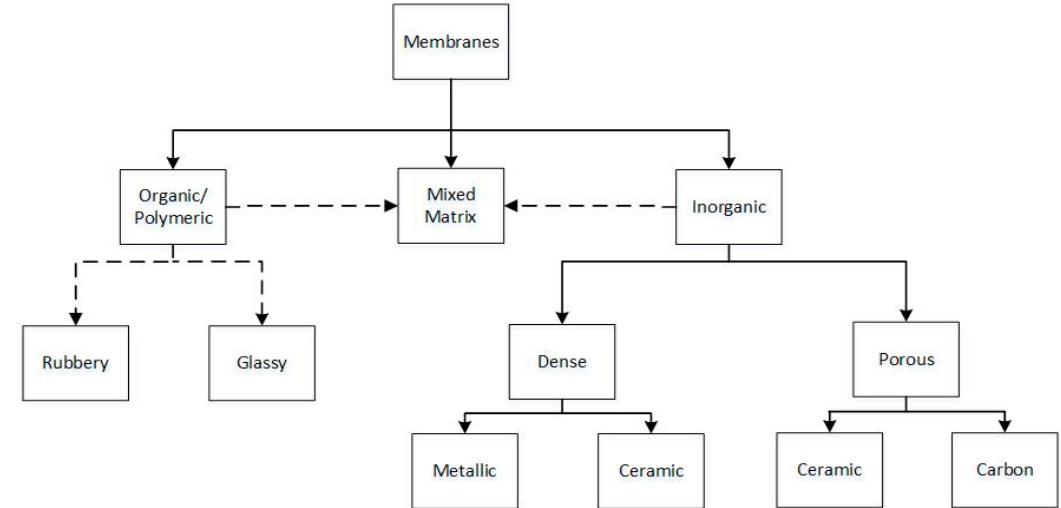
Figure 2. Schematic of membrane classification.